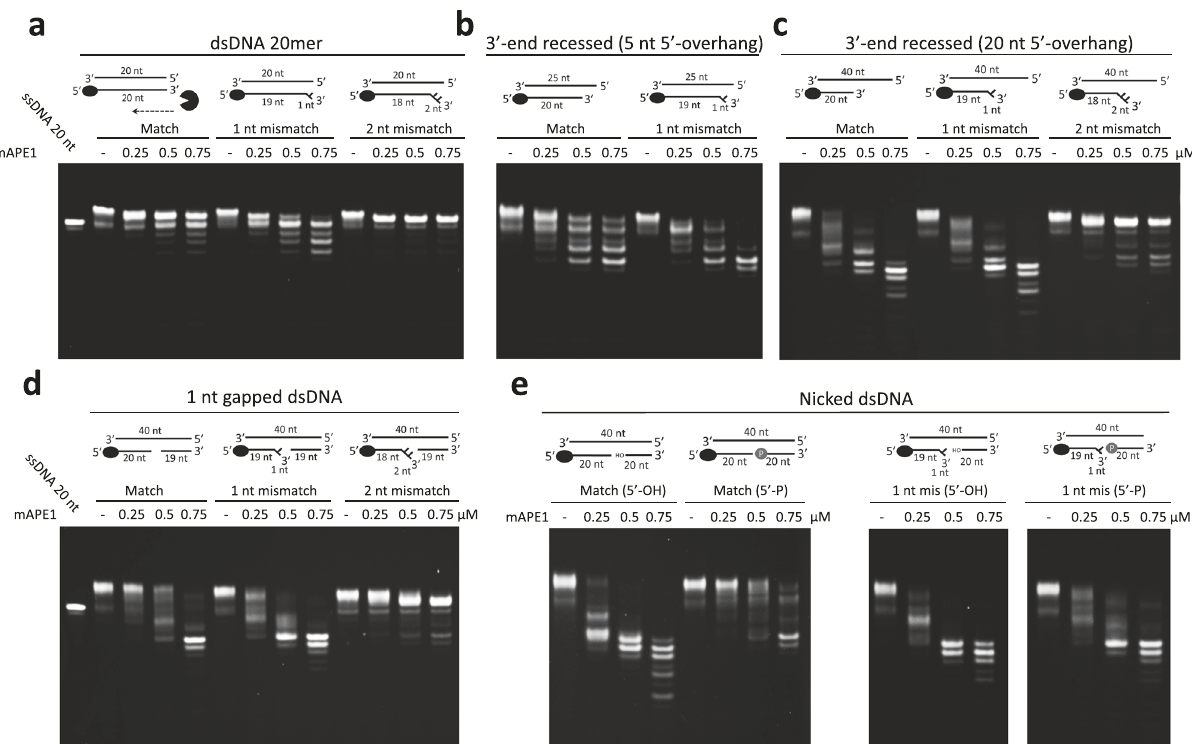
Fig. 3 Structural preference of mAPE1 in exonucleolytic cleavage of various dsDNAs. a The exonuclease activity of mAPE1 in digesting blunt-ended dsDNA 20 mer, dsDNA 20 mer with 1-nt mismatched base pair, and dsDNA 20 mer with 2-nt mismatched base pair. b , c The exonuclease activity of mAPE1 in digesting recessed dsDNA. The substrates are matched or 1-nt mismatched recessed dsDNAs with 5 – nt 5 ′ -overhang and matched or mismatched (1 nt and 2 nt in the length) recessed dsDNAs with 20-nt 5 ′ -overhang. d The exonuclease activity of mAPE1 in digesting 1-nt-gapped dsDNAs. The gapped DNAs are matched, or contain 1 – or 2-nt mismatched base pair at the 3 ′ -terminus of the gapped site. e The exonuclease activity of mAPE1 in digesting matched or 1-nt mismatched nicked dsDNA. The nicked dsDNAs are with phosphoryl or hydroxyl groups at the 5 ′ margin. a – e Source data are provided as a Source Data fi